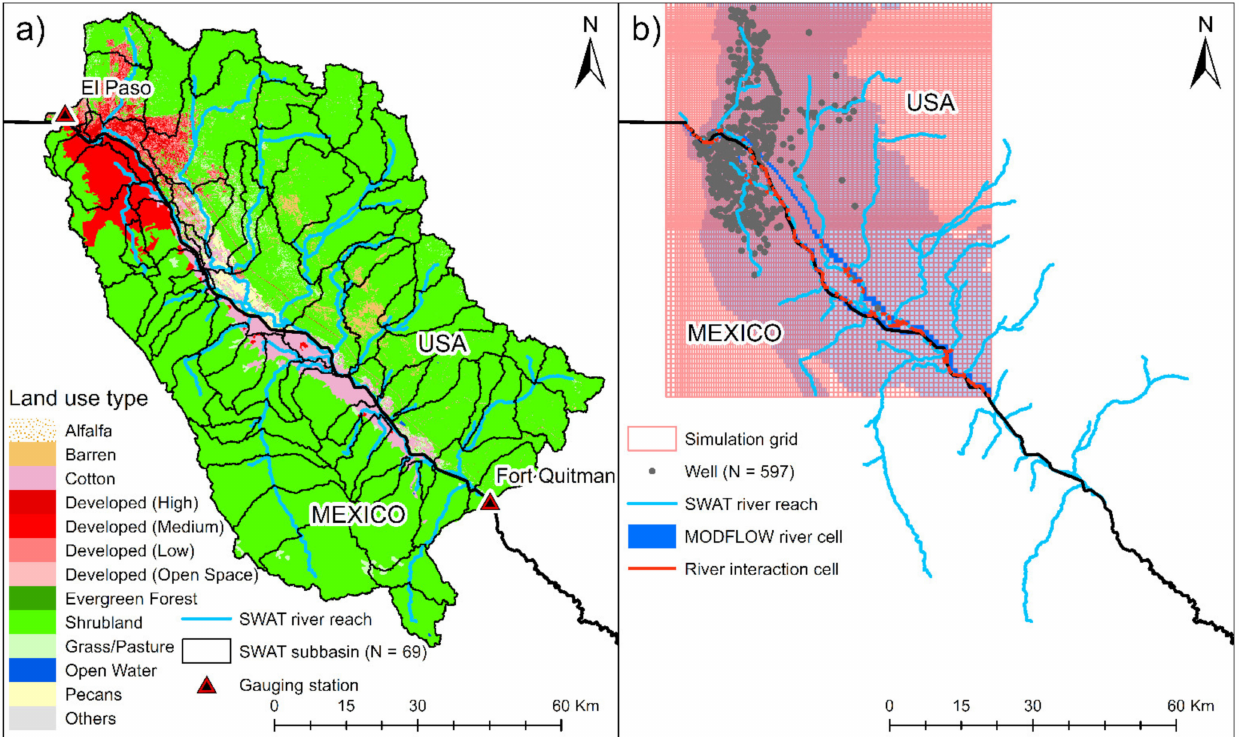
Figure 4. ( a ) Distribution of subbasins of Soil and Water Assessment Tool (SWAT) model superimposed over the land use type across the study area; ( b ) the location of wells, and river interactions between SWAT river reach and groundwater (MODFLOW) river cell used for the surface–subsurface